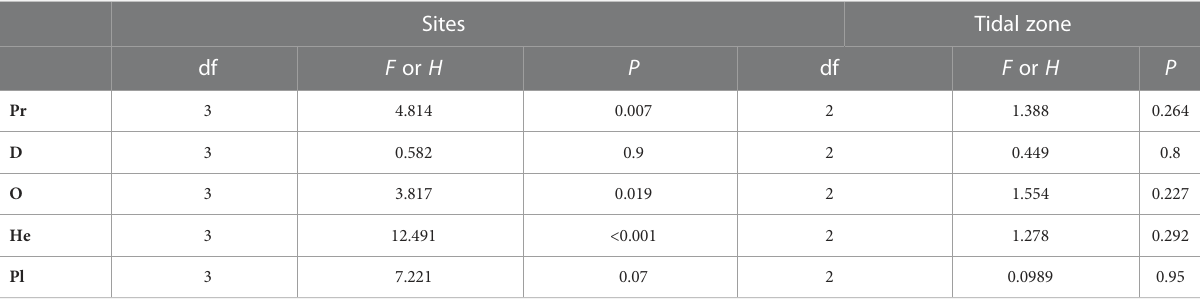
TABLE 5 Effect of study site and tidal zone on macrobenthos functional group abundance in the constructed intertidal oyster reef in Yangtze River Estuary during 2016-2017.